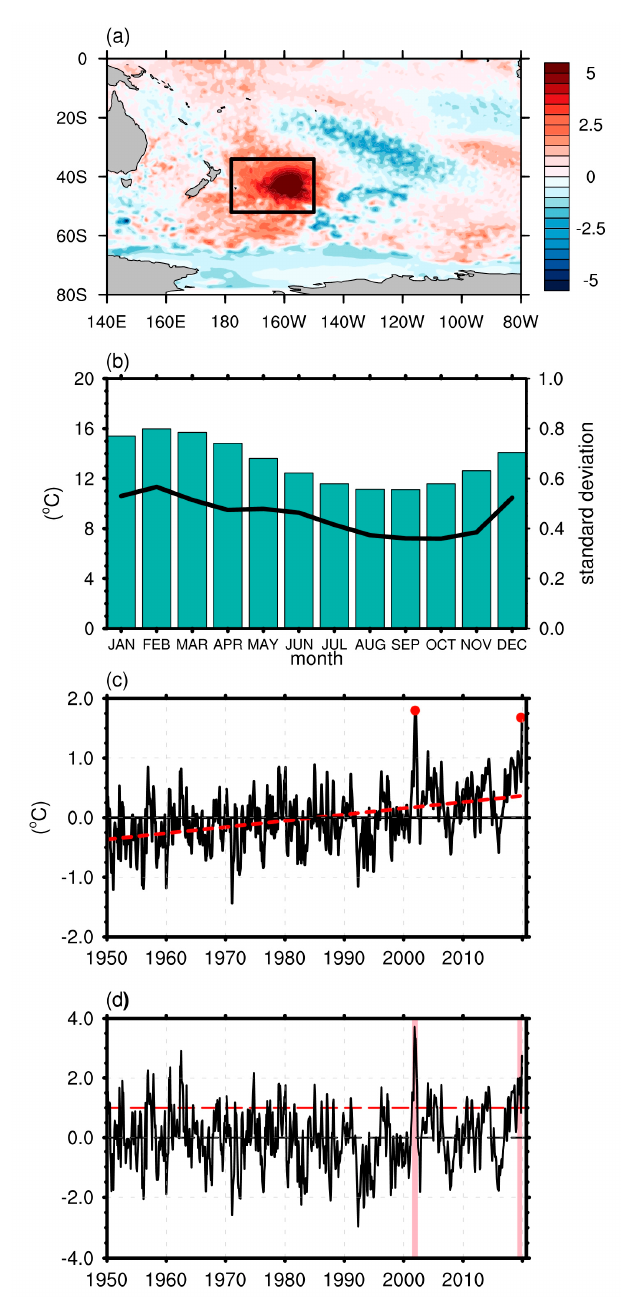
Figure 1. ( a ) The sea surface temperature anomaly (SSTA) (shading, in °C) in South Pacific on 25 December 2019. Black box indicates the blob area (34° S–52° S, 150° W–178° W). ( b ) The climatological monthly SST (green bar, left axis, in °C) averaged over blob area. The black line depicts its monthly SD (right axis). ( c ) The SSTA time series of blob area from 1950 to 2019. Red-dashed line indicates its linear trend using linear regression. The red dots represent the values in December 2001 and 2019, respectively. ( d ) The normalized SSTA time series of the blob area from 1950 to 2019. The pink shading indicates the duration of two extreme cases when the time series was larger than 1.0 SD. The red dashed line denotes the threshold of 1.0 SD.